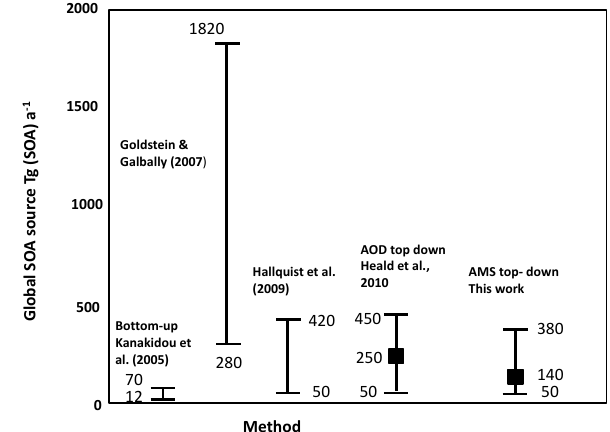
Fig. 12. Annual mean net (long wave and short wave) top of at- mosphere cloud albedo radiative forcing (RF) due to anthropogenic pollution controlled SOA for a cloud updraft velocity of 0.4ms − 1 .